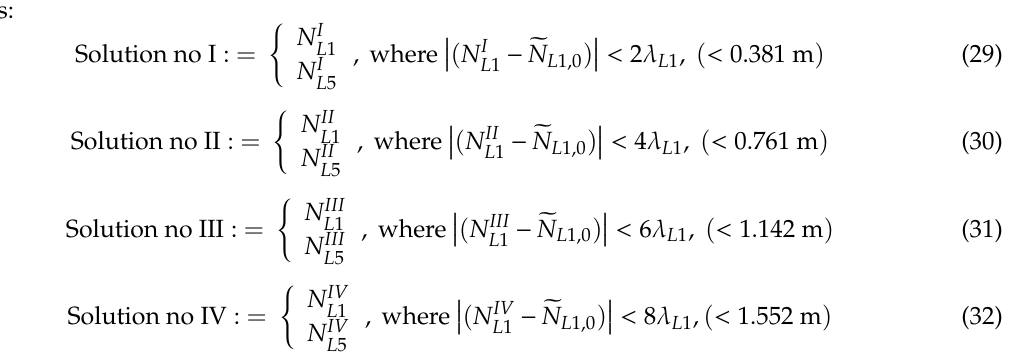
Table 1. DD observations for the G01–G06 satellite pair.